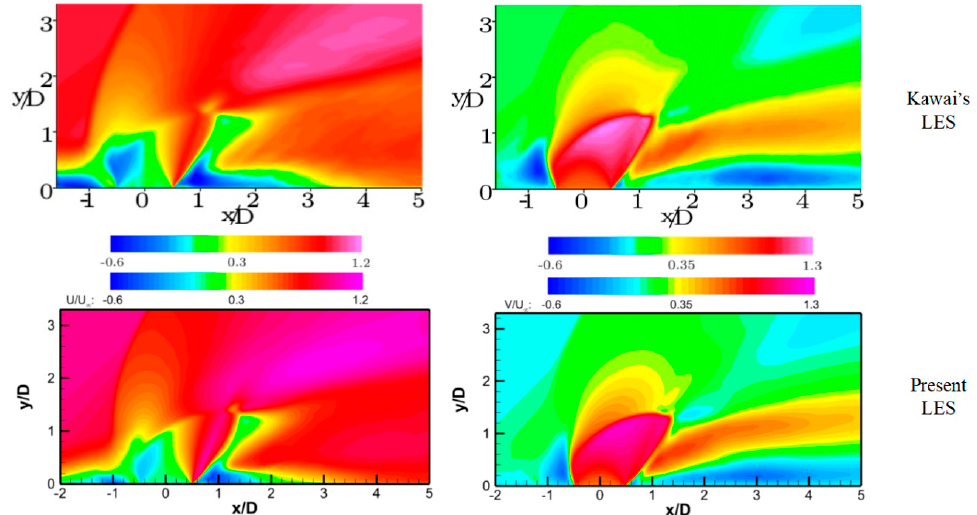
Figure 4. Streamwise and wall-normal velocities, U / U ∞ and V / U ∞ , at the midline plane of z / D = 0. The top two results are the LES results published by Kawai in [31], the bottom two results are the present LES results.